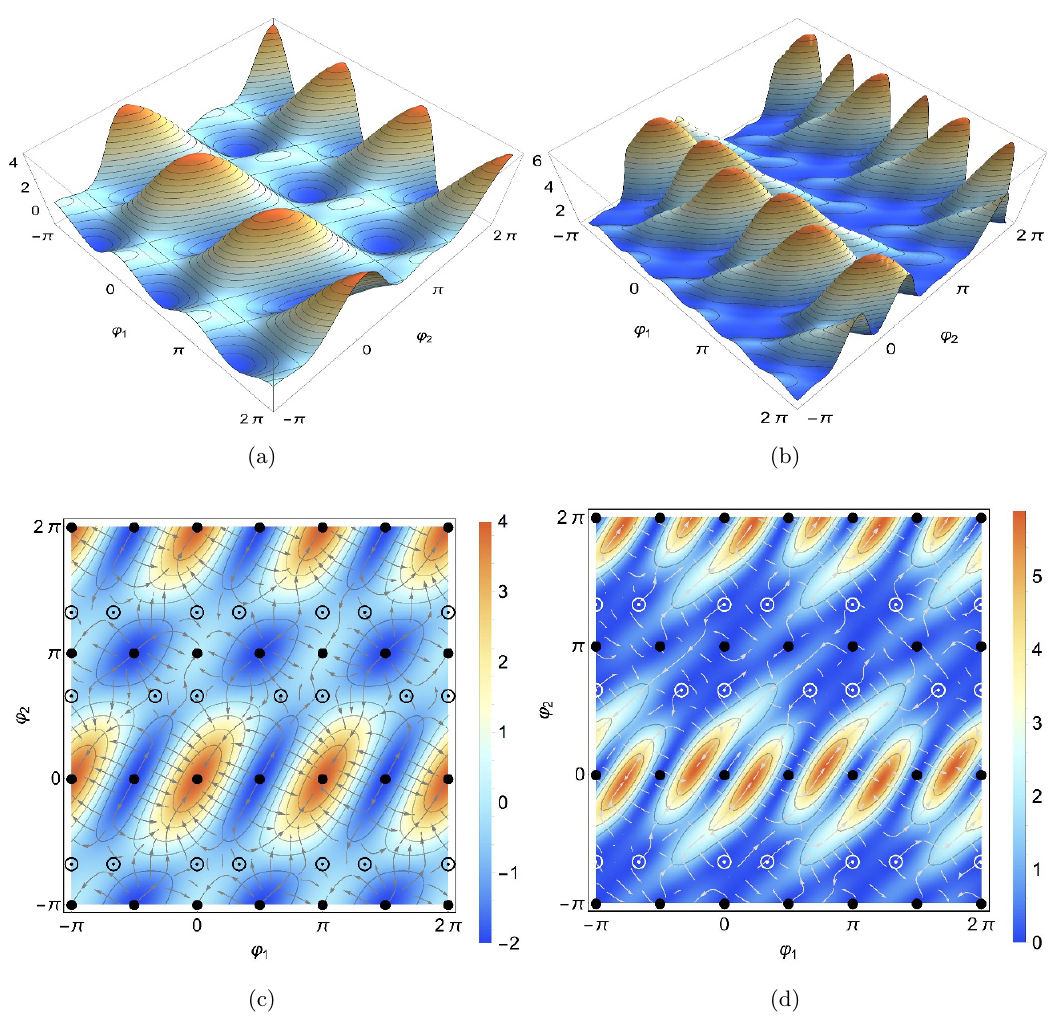
Figure 3 . (a), (c) The pre-potential (4.31) and (b), (d) the potential (4.34). The vacua (4.36) are given by the black dots, (4.37) by (cid:12) and the lines stand for the gradient (cid:13)ow of ~ r U and ~ r V , where ~ r = ( @ ’ 1 ; @ ’ 2 ). Here (cid:13) 1 = (cid:13) 2 = (cid:13) 3 = (cid:13) 4 = 1 and (cid:21) =